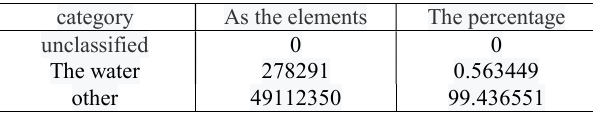
Table 4-1 Statistical results of surface water distribution in